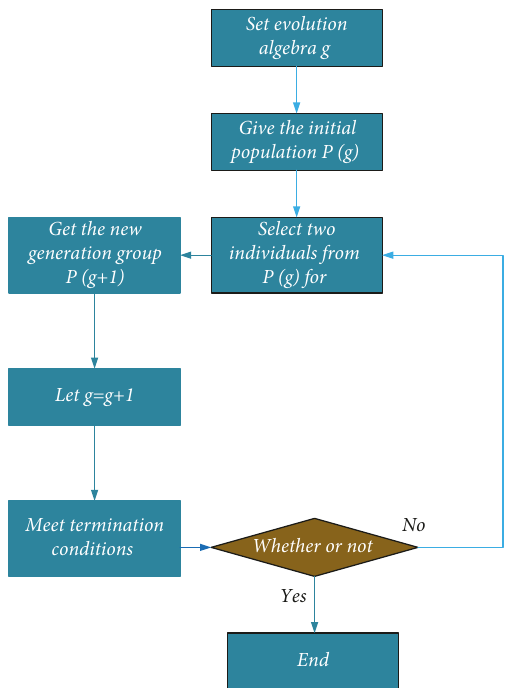
Figure 6: Algorithm